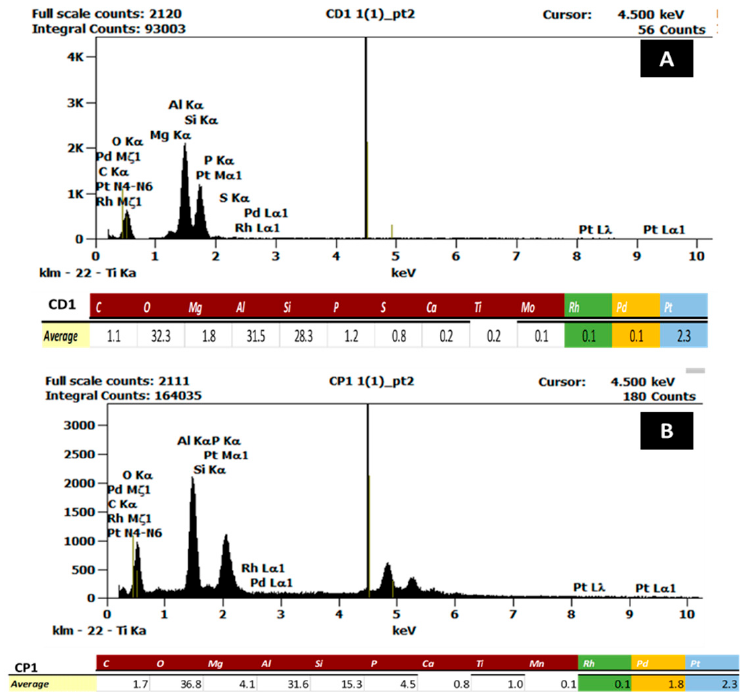
Figure 5. The energy dispersive x-ray (EDX) analysis images of ( A ) diesel (D) and ( B ) petrol (P) spent catalytical converters.